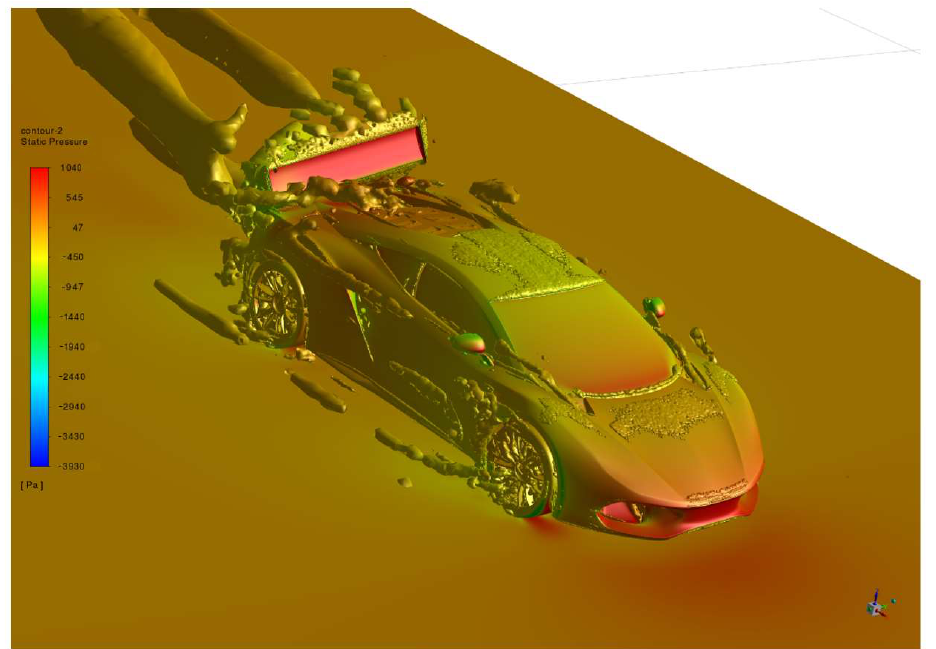
Figure 22. Pressure 0distributions on the car surface and the iso-surface dimensionless. parameter Q = 0.1 in the braking wing configuration obtained from the RANS simulations.